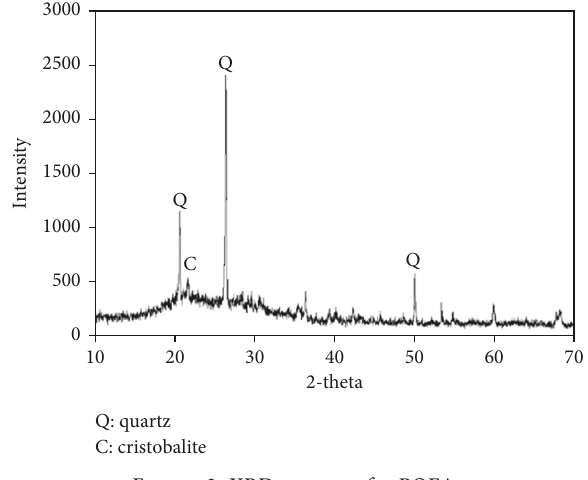
Figure 3: XRD pattern of